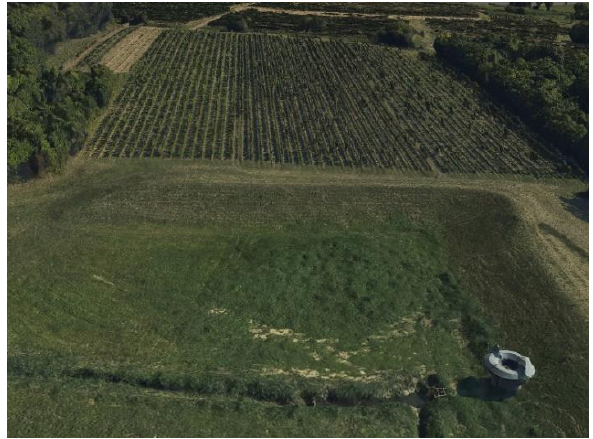
Figure 4. 3D model of vineyards in research area with the re- tention